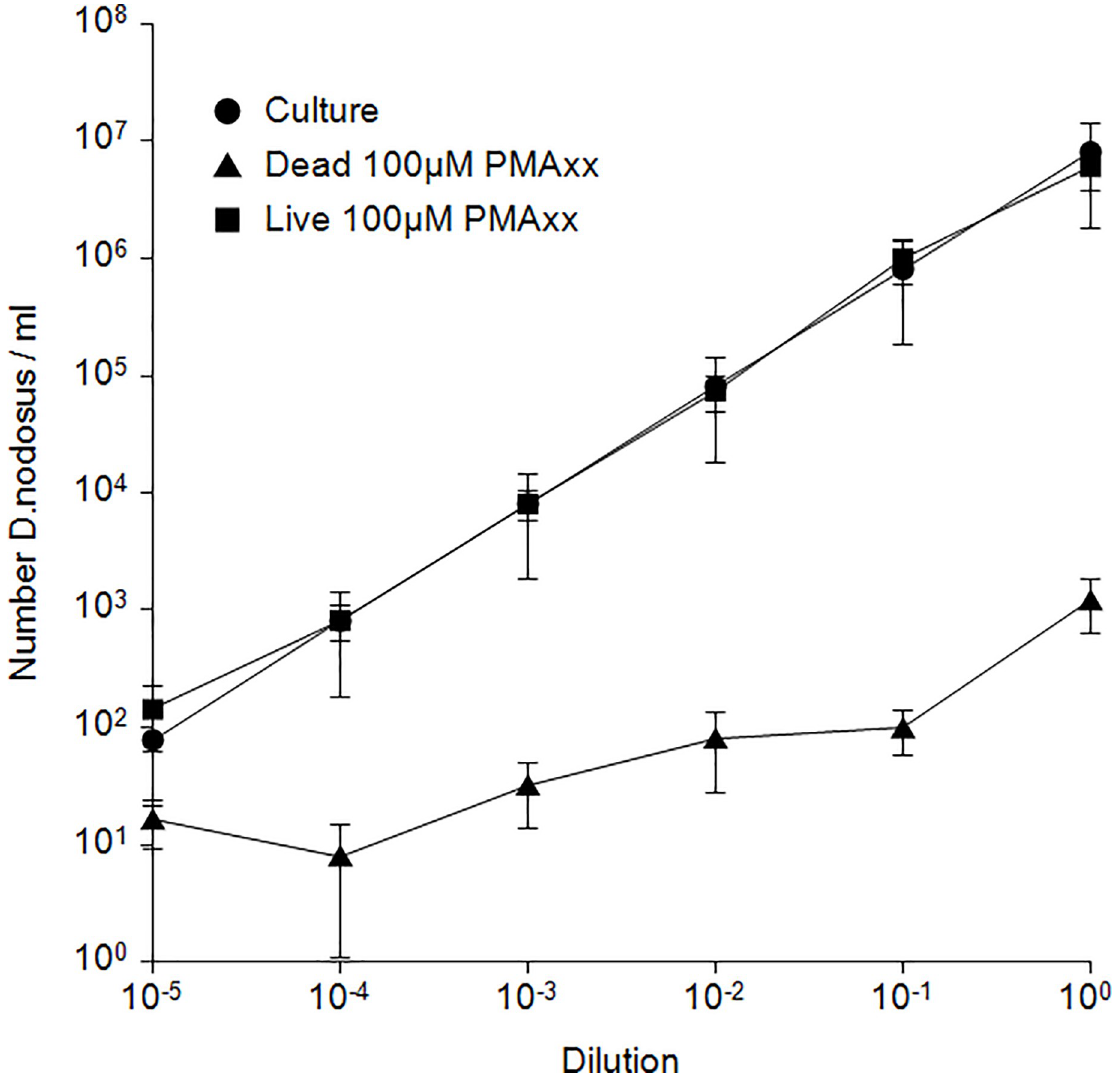
Fig 2. Number of viable and heat killed D . nodosus determined by culture and PMA-qPCR. Six mock samples of tenfold serial dilutions were used to demonstrate the linear range of established PMA-qPCR. Three independent runs were performed and average values calculated. Error bars represent standard